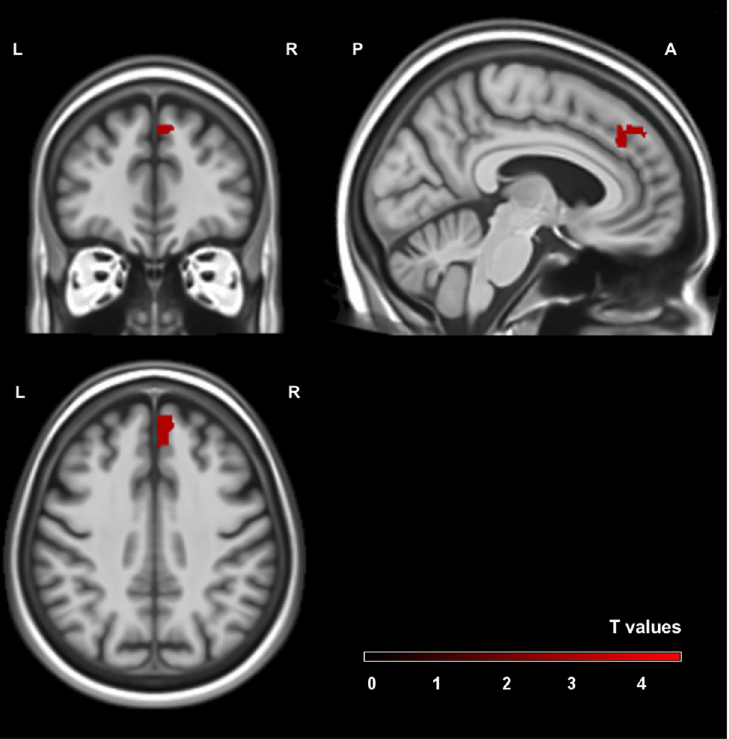
Figure 3. Second cluster ( 2 ) of the voxel-based lesion symptom mapping analysis. The area is significant at cluster level ( p < 0.05) without permutation-correction with a voxel threshold of p < 0.001. Scale bars represent t-scores. L: left hemisphere, R: right hemisphere, A: anterior, P: